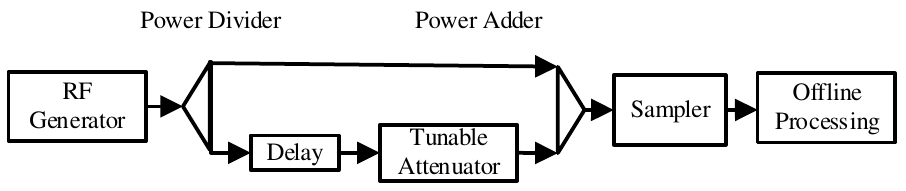
Figure 11. Measure set-up equipped for the laboratory test on the range resolution.